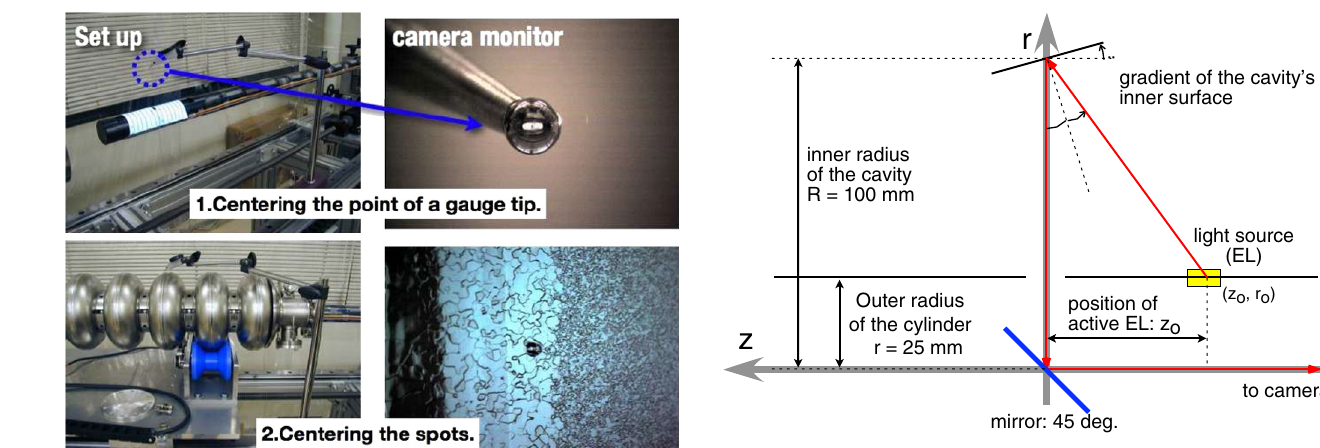
ON/OFF.FIG. 7. (Color) Pointer to confirm the position monitored by the camera on the outer wall of a cavity.